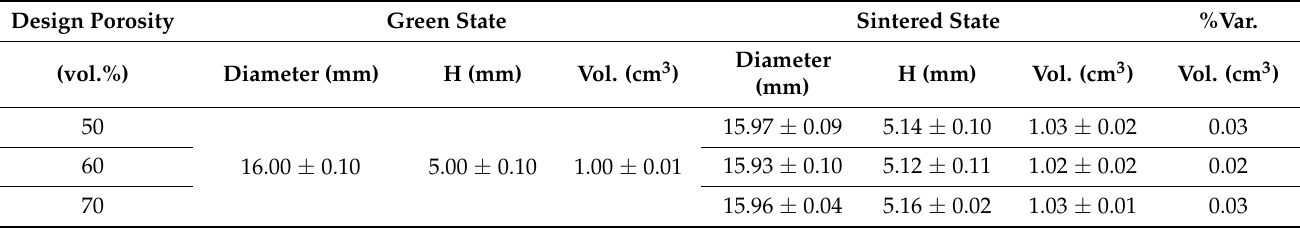
Table 1. Dimensional analysis of the foams.